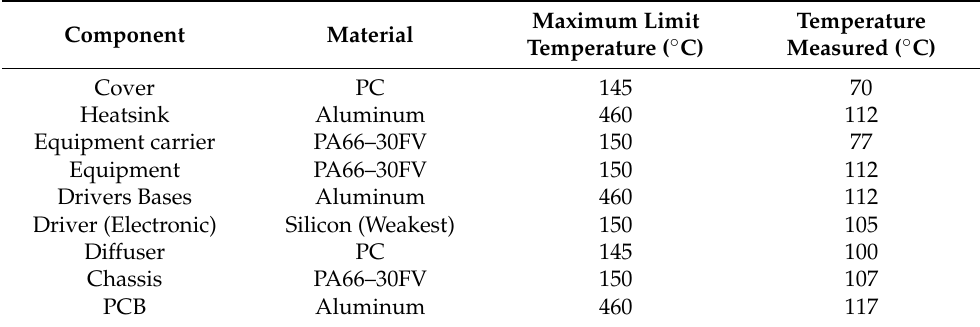
Table 3. Maximum temperature limit of the material versus temperature measured in the different parts of the Model at 20 ◦ C. Source: our own elaboration.